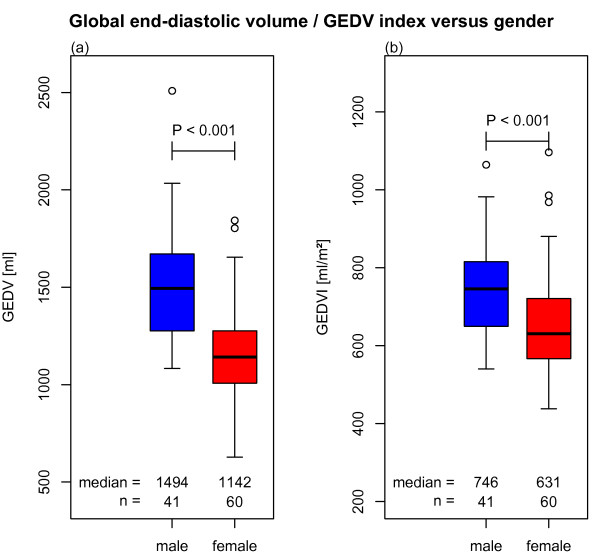
(a) Global end-diastolic volume (GEDV) and (b) global end-diastolic volume index (GEDVI) versus gender (univariate comparison).